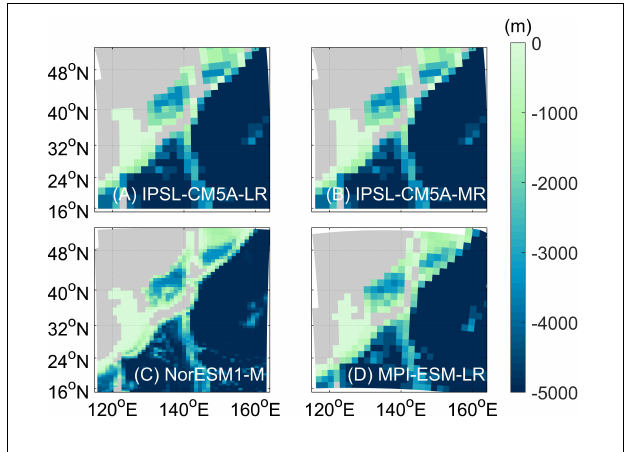
FIGURE 2 | Bottom topography (unit: m) of: (A) IPSL-CM5A-LR (GCM-IPSL-L), (B) IPSL-CM5A-MR (GCM-IPSL-M), (C) NorESM1-M (GCM-Nor), and (D) MPI-ESM-LR (GCM-MPI) with gray land mask.